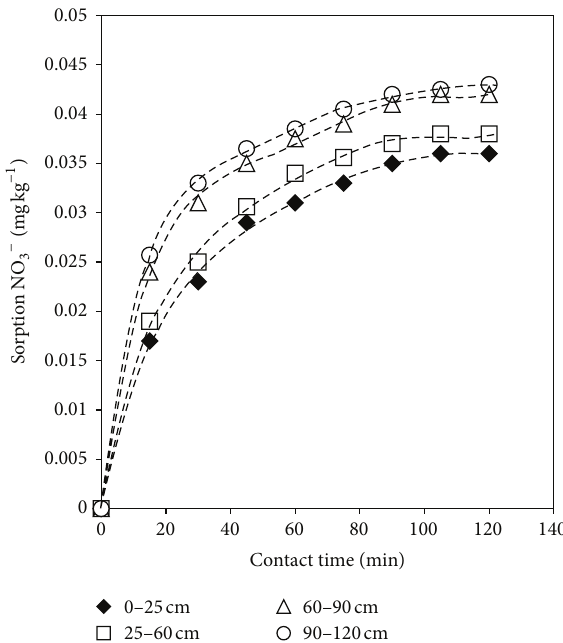
Figure 1: Effect of contact time on NO 3− sorption for 4 soil depths from a batch experiment using an iso-humic soil from Chott Meriam, Tunisia. (Initial conditions for the batch experiment were 100mg NO 3− L −1 , 22 ∘ C, and 5g air-dried soil).